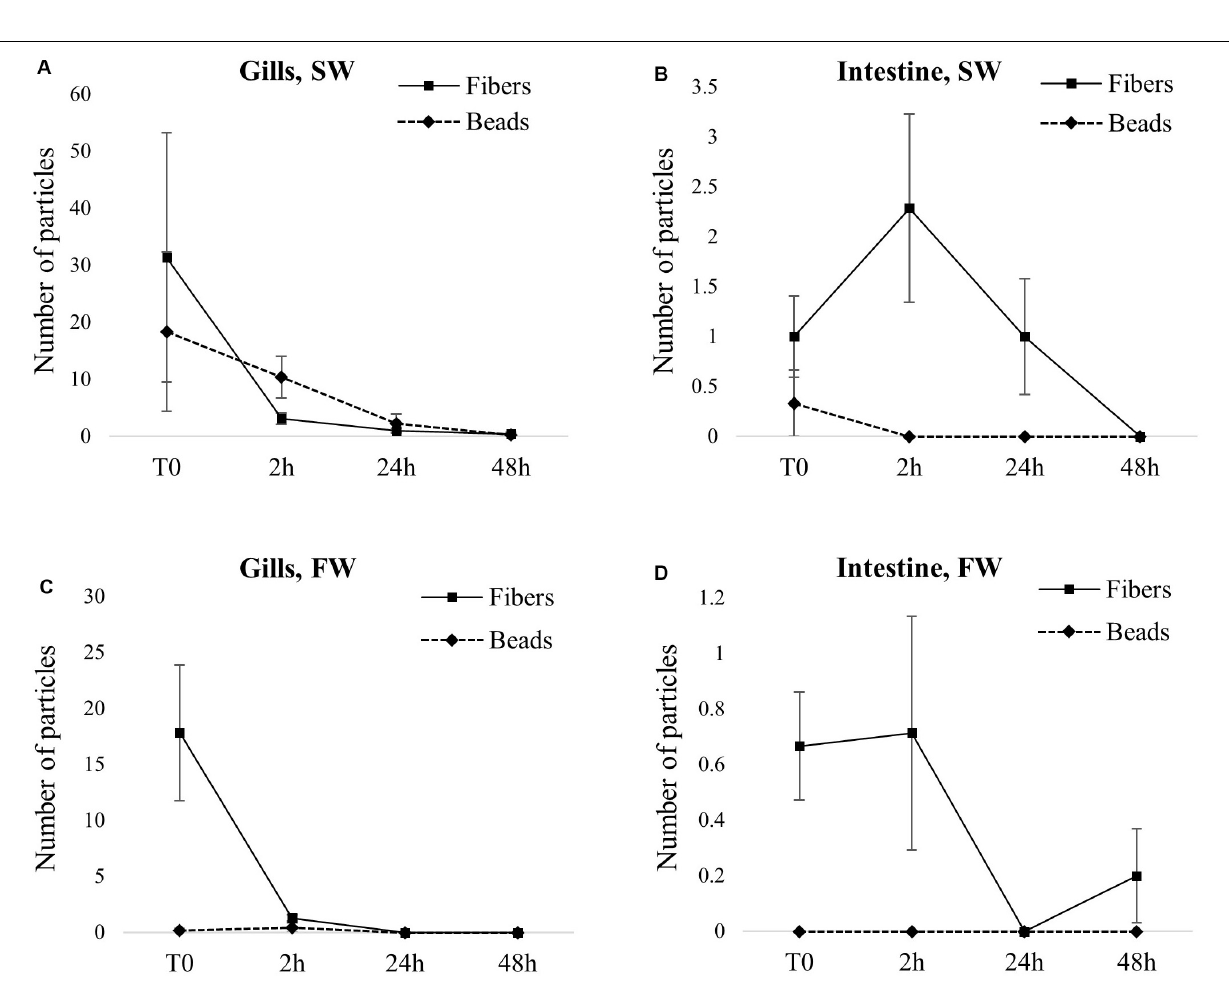
Frontiers in Environmental Science |